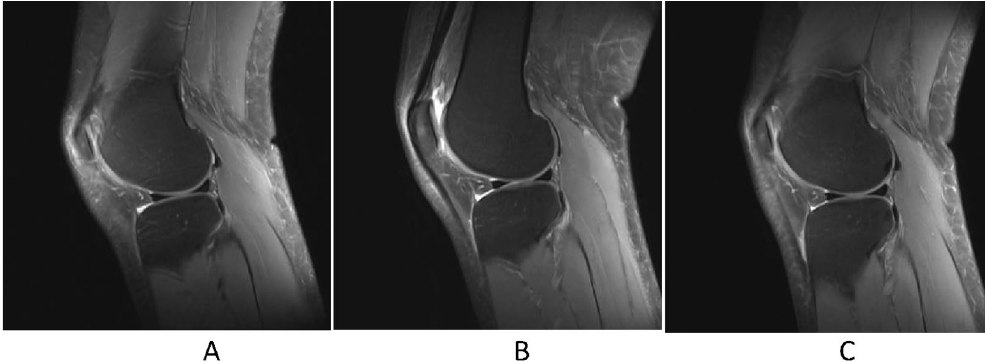
Figure 2. Representative images demonstrating the state of the meniscus and cartilage. Specifically, these FS ‐ PDWI images of the left knee in a 28-year-old female show that the cartilage was continuous and complete with a smooth surface, lacking obvious abnormal signal changes, meniscal tears, ligament or tendon injuries, subchondral bone changes, free bodies, or joint effusions when assessed 1 week before the marathon ( A ) and 12 h ( B ) or 2 weeks ( C ) after marathon running.